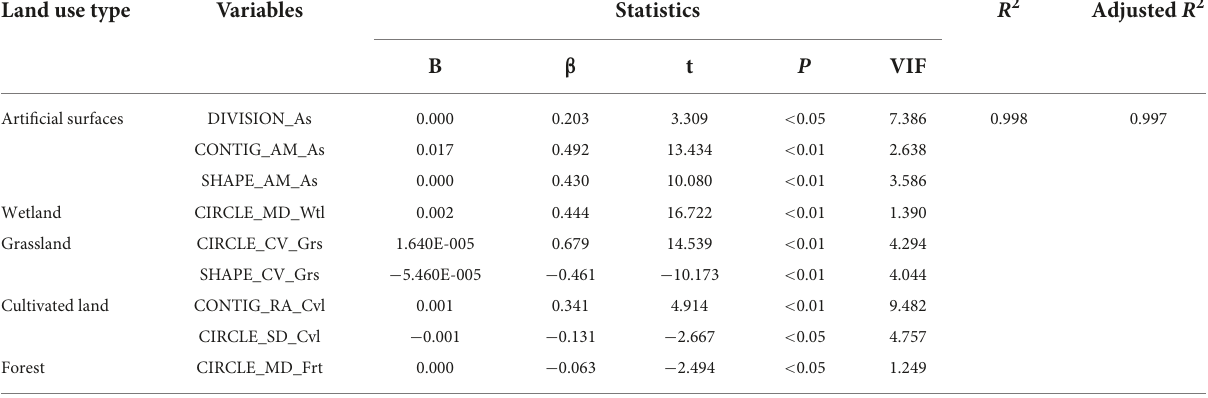
TABLE 5 Multiple regression analysis results obtained for the leading landscape patterns in the urban subcenter area.